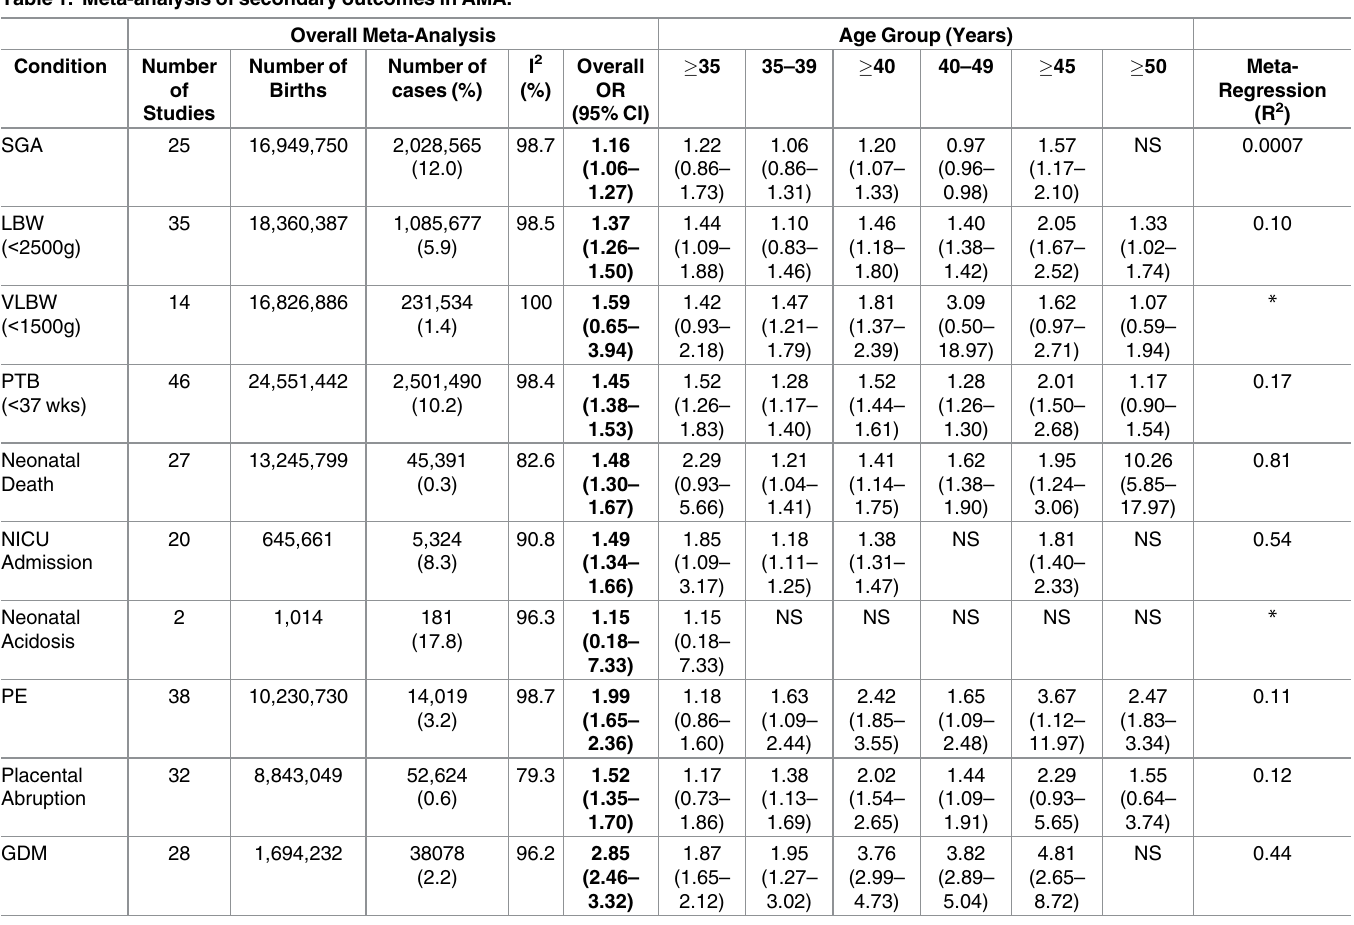
Table 1. Meta-analysis of secondary outcomes in